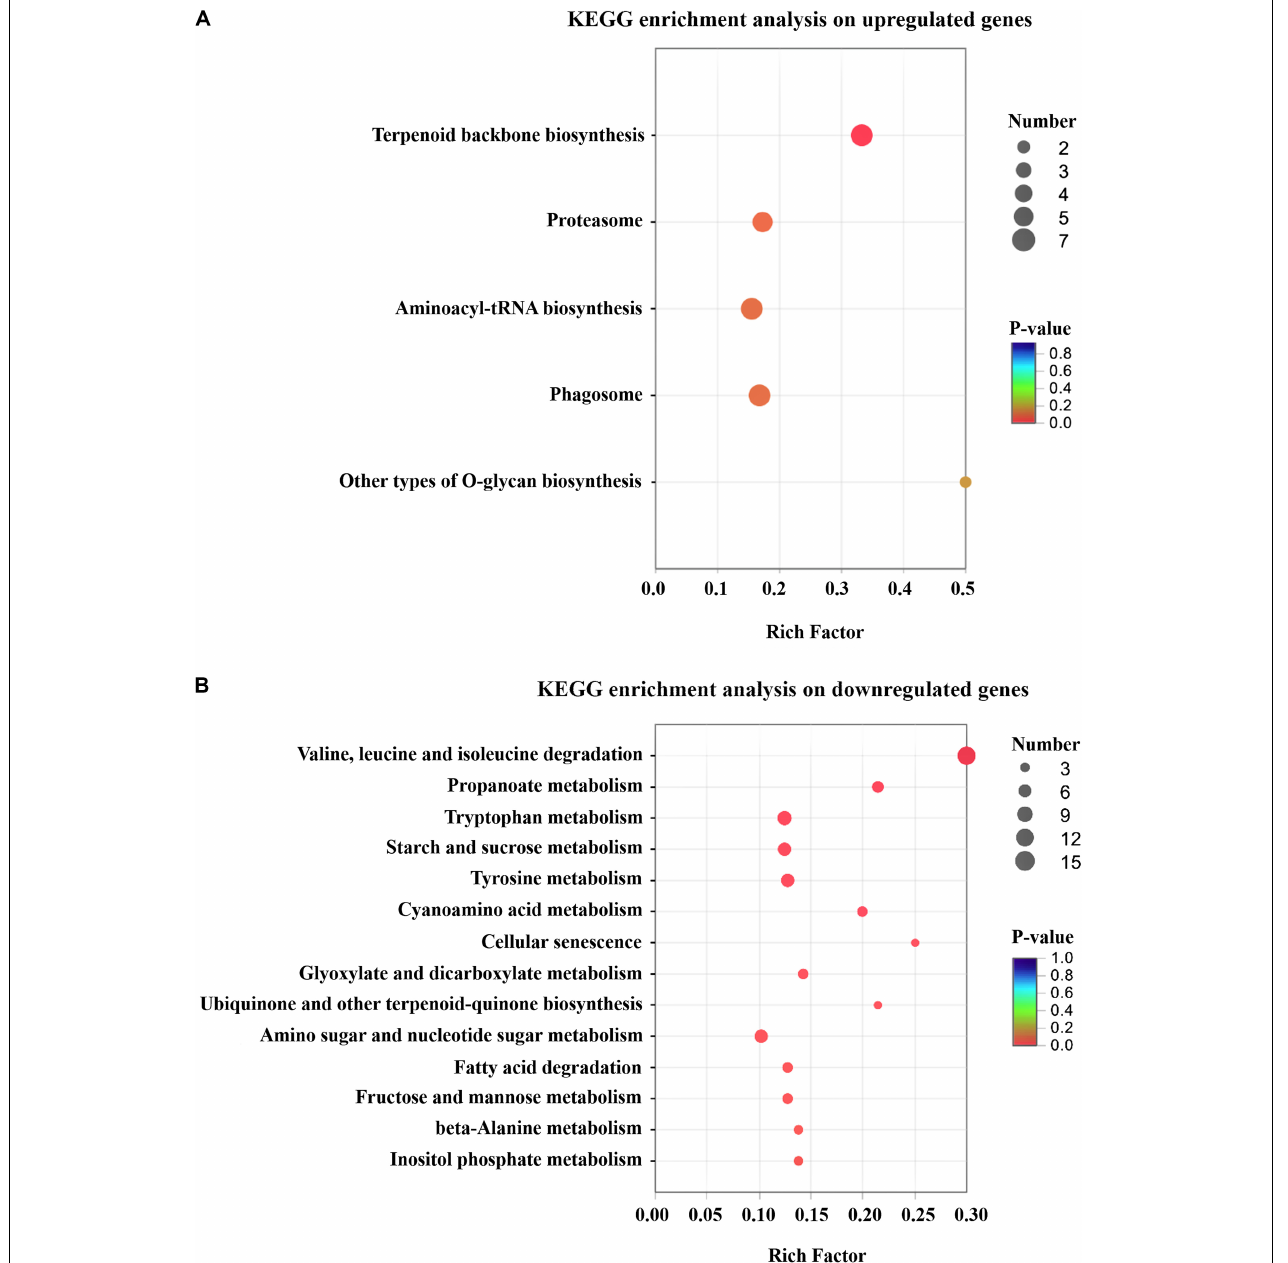
FIGURE 4 | KEGG pathway enrichment analysis of the changed genes. Results of the up-regulated (A) and down-regulated (B) genes in T. harzianum LZ117 relative to T. harzianum K223452 were presented. The degree of KEGG enrichment is assessed by the P -value and rich Factor. The X axis represents Rich factor (the ratio of the number of DEGs (sample numbers) enriched in the pathway to the number of all the annotated genes/transcripts mapped to the corresponding KEGG pathway (Background number). The size of the dot indicates the number of genes in this pathway, and the color of the dot corresponds to a range of different P -values ( < 0.05). The closer the P -value is to zero, the greater the Rich factor is, which means that the more the enrichment is